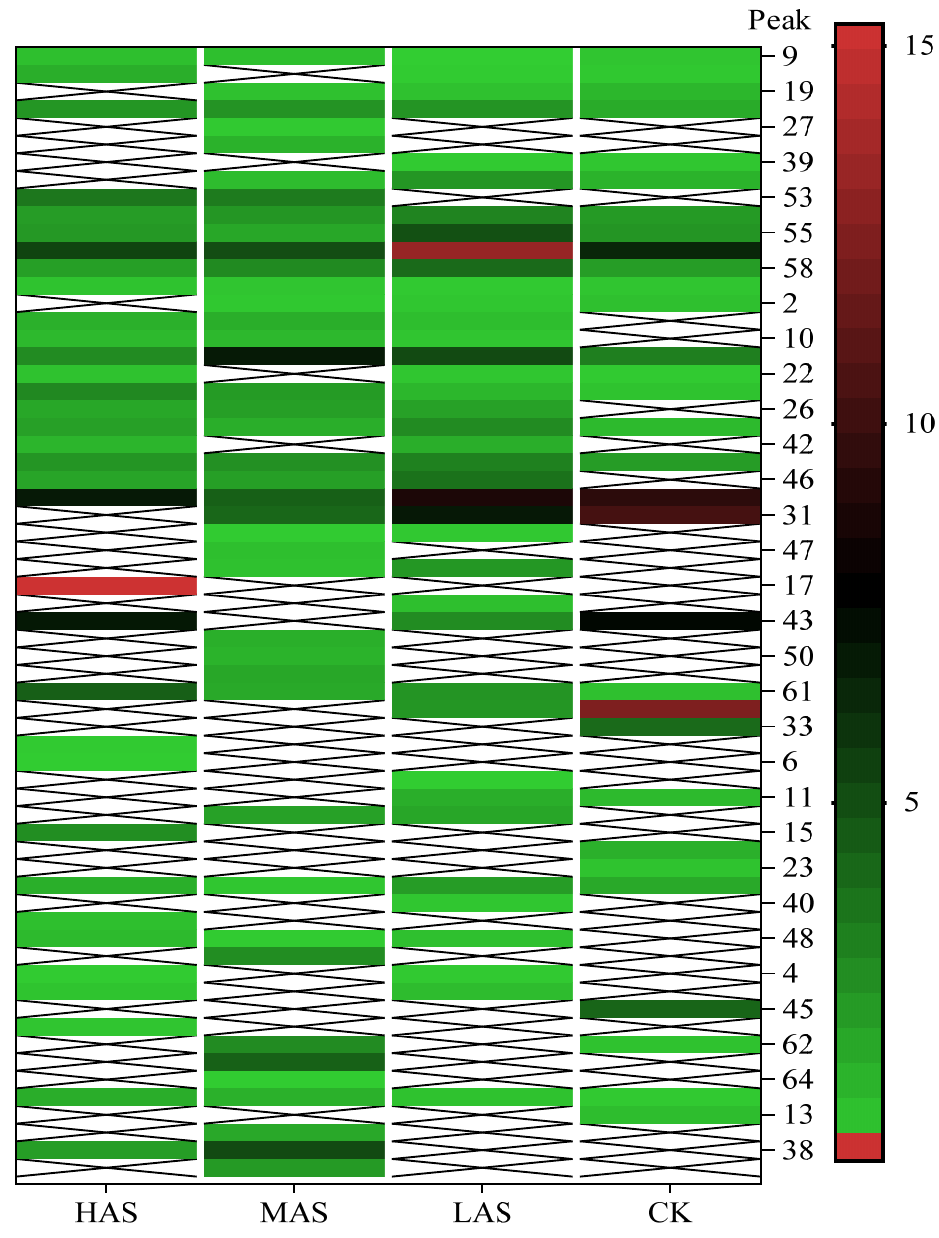
Figure 3. The heatmap of compounds in four An–tea samples at different aging times. Table 3. Eigenvalues and contribution rates of first three principal components. Principal Eigenvalue Component